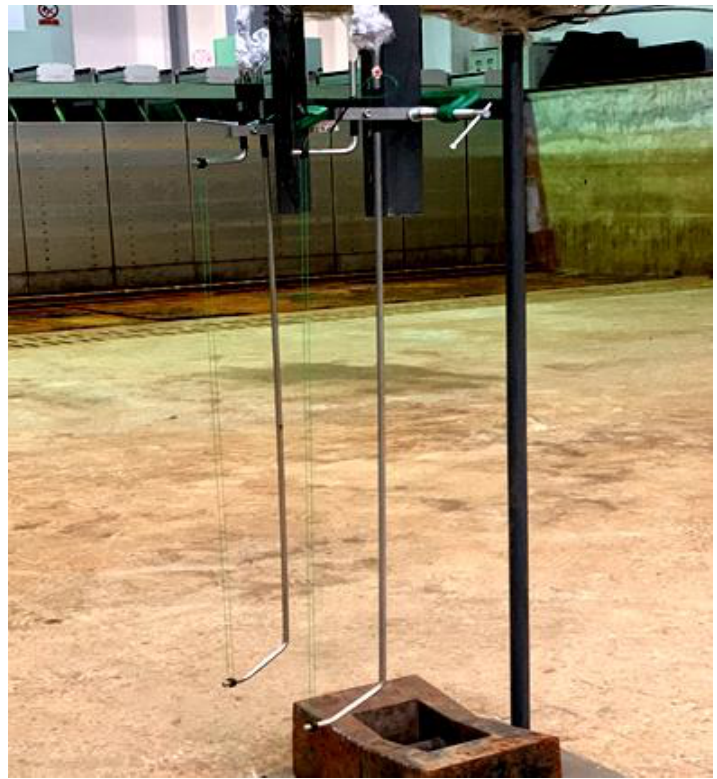
Figure 7. The wave gauge in the